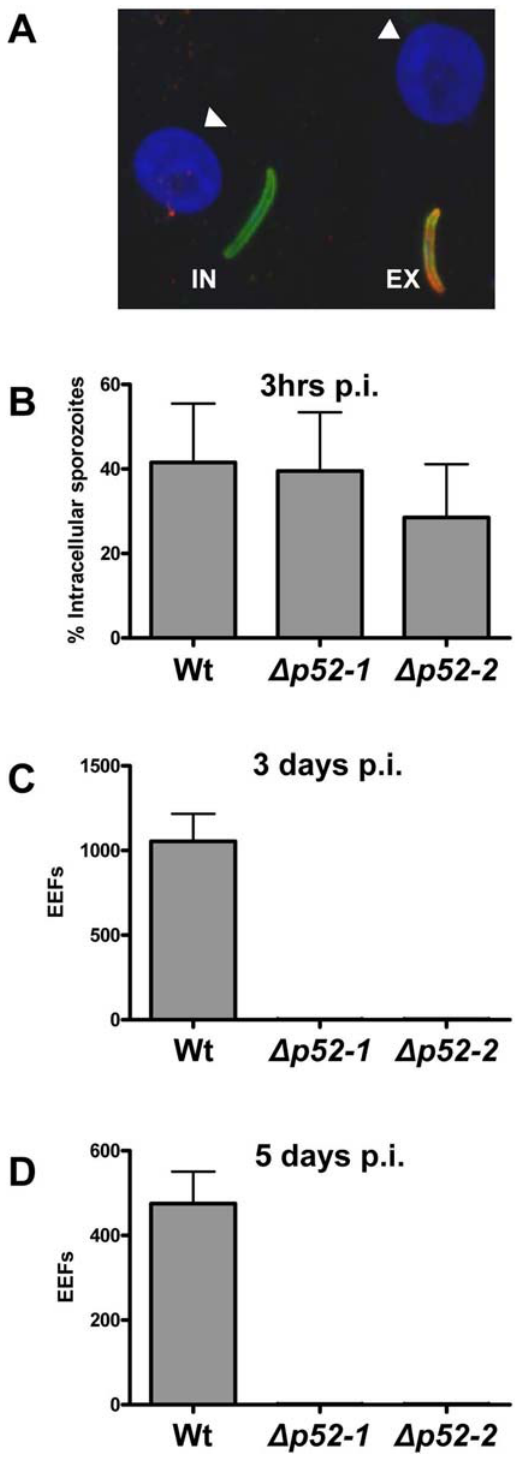
Figure 3. Invasion capacity of Wt and D p52 sporozoites in primary human hepatocytes invitro . (A) Intra (In) and extracellular (Ex) sporozoites 3 hrs after incubation of sporozoites with primary human hepatocytes in culture. Sporozoites were first stained with anti- PfCSP antibodies (red). Then cells were permeabilised and sporozoites were stained with anti-PfCSP antibodies (green). Consequently, extracellular sporozoites will stain red AND green and intracellular sporozoites will stain only green. Nuclei of the hepatocytes (white arrow heads) were stained with DAPI (B) The percentage of